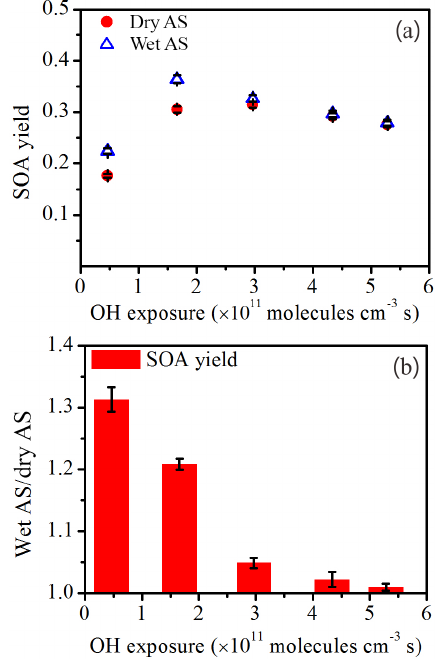
Figure 2. (a) Yield of toluene-derived SOA formed on initially wet and dry AS as a function of OH exposure. (b) Ratio of SOA yields on initially wet AS to those on initially dry AS as a function of OH